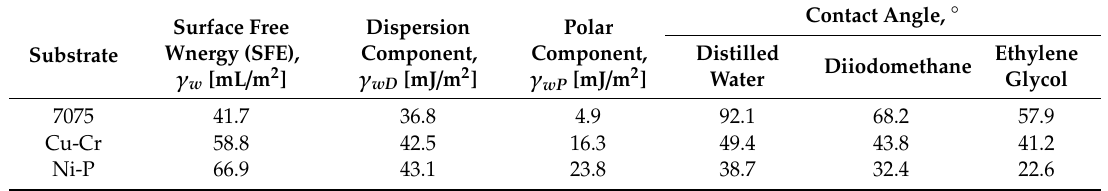
Table 4. Surface free energy and wettability of electrodeposited coatings and 7075 aluminum alloy substrates.